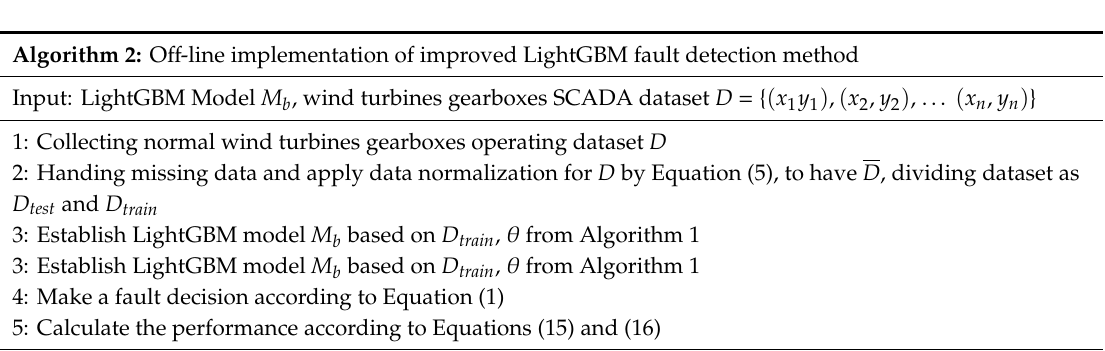
Algorithm 2: O ff -line implementation of improved LightGBM fault detection